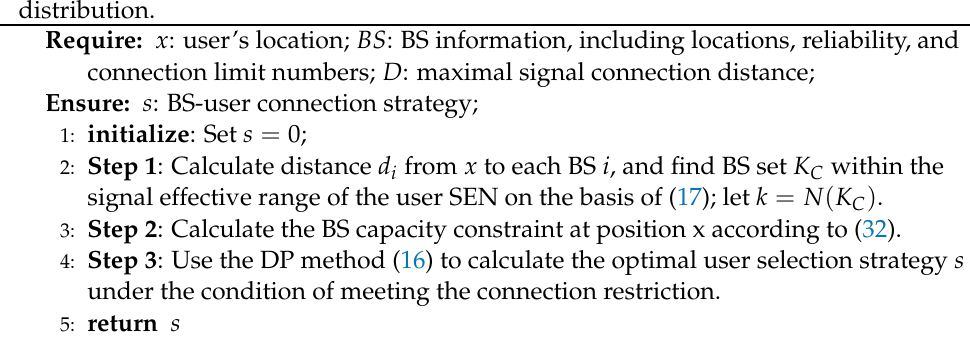
Algorithm 1: Wireless BS selection-strategy optimization based on identified